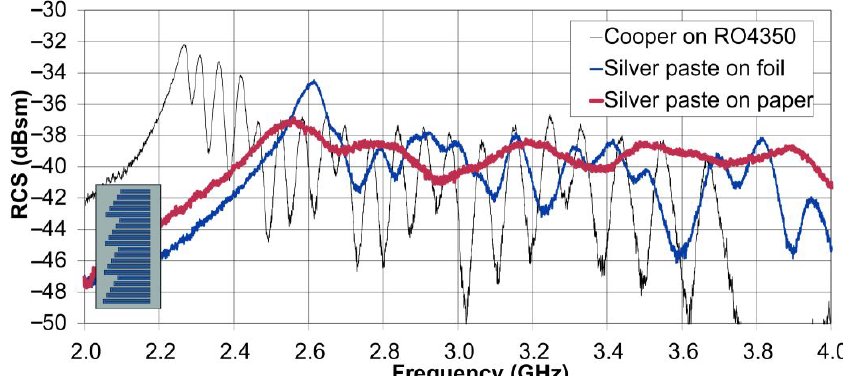
Figure 13. Measured RCS of shorted re-arranged U-dipole tag manufactured by the screen-printing technology on Folanorm polyester film and a paper substrate compared to a standard copper-on- microwave substrate technology.